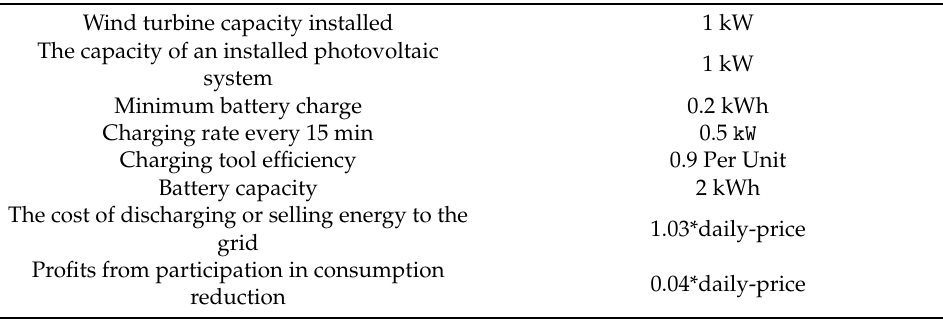
Table 2. The parameters and numerical values for solving the problem.